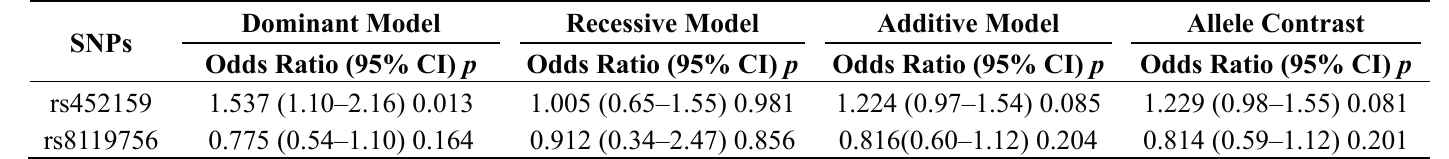
Table 3. Logistic regression analysis for rs452159 and rs8119756 under different contrast models adjusted for age, sex, and cardiovascular risk